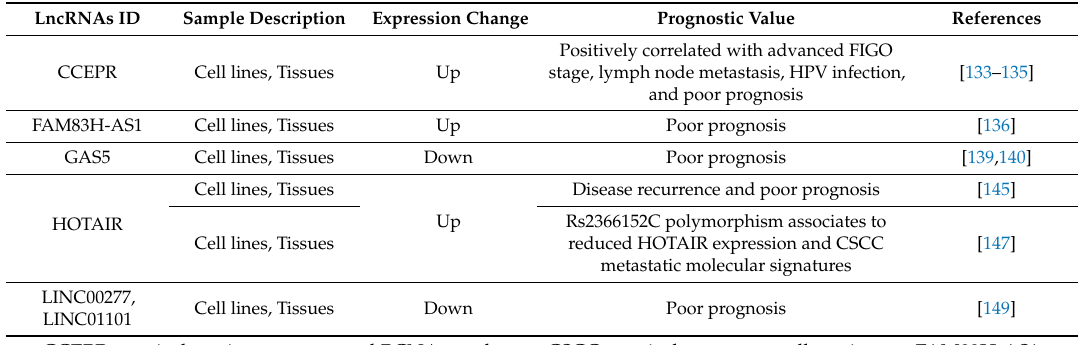
Table 3. Prognostic value of long non-coding RNAs (lncRNAs) modulated by Human Papilloma Virus E6 / E7 oncoproteins in cervical squamous cell